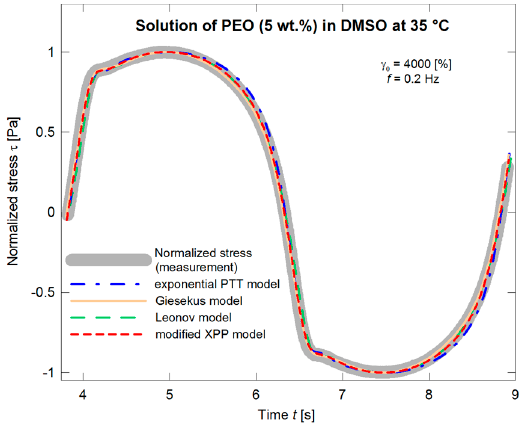
Figure 12. Optimization of the exponential PTT, Giesekus, Leonov, and modified XPP models with respect to the normalized stress amplitude.